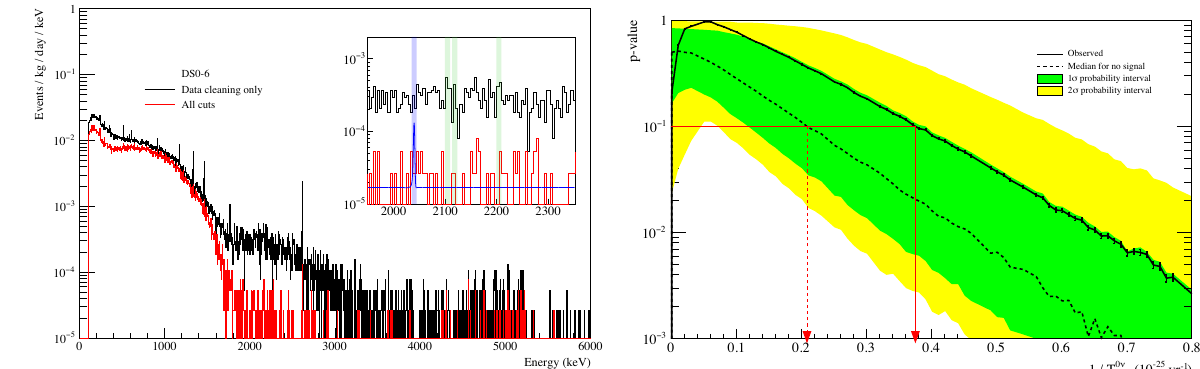
Figure 11. Left : energy spectrum above 100 keV with only data cleaning and muon veto cuts (black) and after all cuts (red). FIG. 9. Color online. Energy spectrum above 100 keV of FIG. 11. Color online. The p-value as a function of all seven data sets summed together with only data clean- The blue curve shows the fitted background from the unshaded regions in the inset and the 90% C.L. upper limit on the  (0 ⌫ ) half-life obtained from the unbinned frequentist ing and muon veto cuts (black) and after all cuts (red). The profile-likelihood method for DS0-6 (solid black). The counts from a 0 νββ signal. Right : the p -value as a function of the 0 νββ half-life estimated from the unbinned frequentist inset shows the same spectra in the background estimation  (0 ⌫ ) half-life in 76 Ge where the p-value of the observed profile-likelihood method (solid black). The median sensitivity is shown as a dashed black line, and the shaded bands window, which spans 1950-2350 keV, with regions excluded Majorana Demonstrator data (solid red line) equals 0.1 due to gamma backgrounds shaded in green and the 10 keV represent the 1 and 2 σ intervals. Figure published by Phys. Rev. C, 2019 corresponds to the lower limit on the half-life. The median window centered on Q  shaded in blue. The solid blue curve sensitivity is indicated with the dashed black line, and the shows the flat background estimated from the unshaded re- shaded bands correspond to the 1 and 2  intervals. gions in the inset plus the 90% CL upper limit on the number